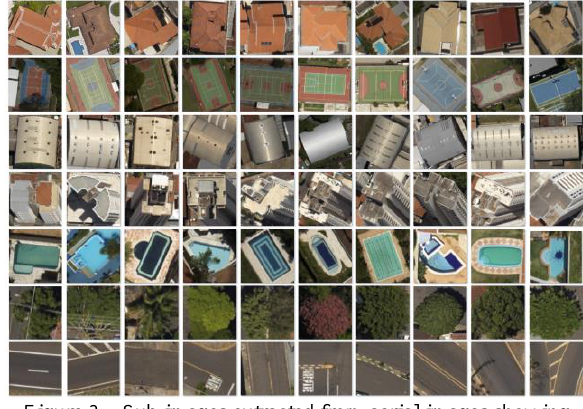
Figure 3 – Sub images extracted from aerial images showing urban objects for CNN training.